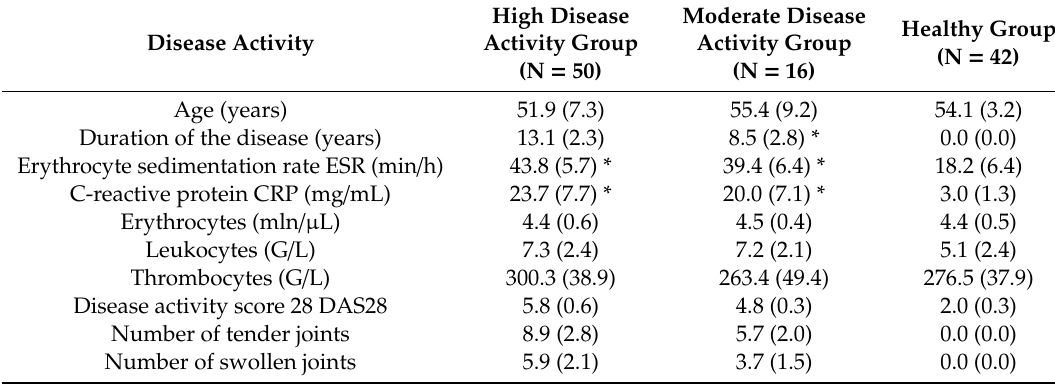
Table 1. Baseline characteristic of rheumatoid arthritis (RA) patients and healthy subjects (N = 108). All data are expressed as the mean (SD).